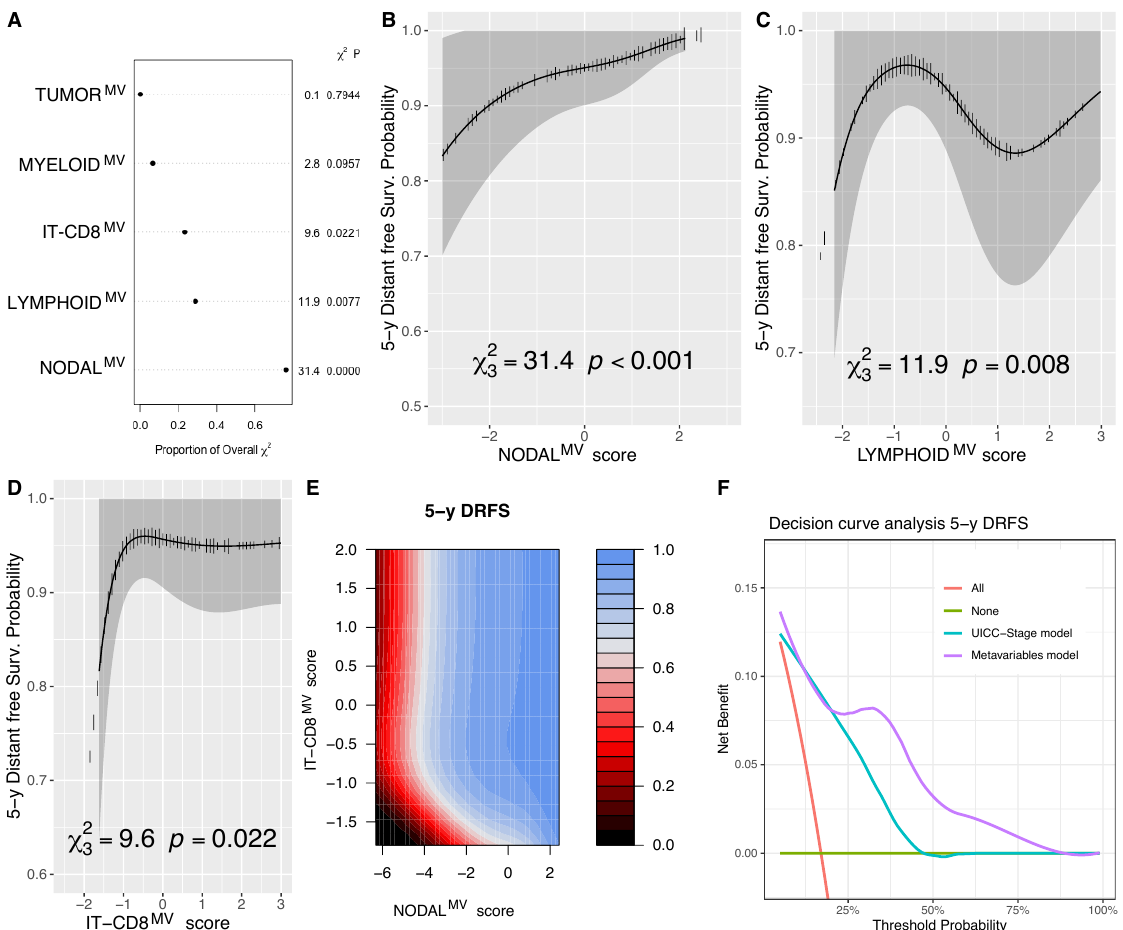
Figure 6. Chunk test results on the DRFS multivariable model reporting the proportion of the overall χ 2 of the model explained by each variable, the partial χ 2 and P value of the Wald test, testing the association between each variable and the outcome ( A ); adjusted marginal effect plots for the 5-year DRFS with CI 95% (gray bands) of the NODAL MV ( B ); LYMPHOID MV ( C ) and IT-CD8 MV ( D ) scores; contour plot showing isoprognostic DRFS bands according to the combined effect of the NODAL MV and IT-CD8 MV scores for the 5-year DRFS estimate—the color scale represents the 5 y DRFS probability ( E ); and decision curve analysis (DCA) showing the better performance of the model including MVs compared to the one fitted with the UICC overall stage alone in predicting the 5-year DRFS ( F